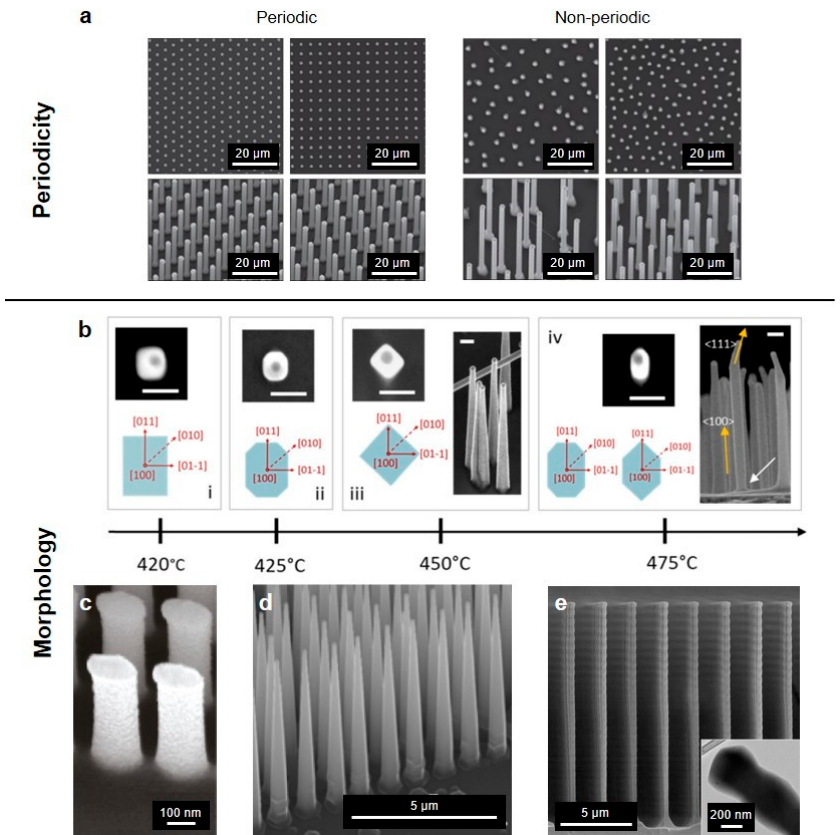
Figure 2. Scanning electron microscopy (SEM) images of geometrical variations in vertical nanowire arrays. ( a ) Periodic and non-periodic array arrangements. Top row: Top-view images of the nanowire arrays. Bottom row: Tilt-view (20°) images. ( b ) Side facets variations of the <100> oriented nanowires along the growth temperature. All scale bars are 100 nm. ( c ) Elliptical cross-section nanowires. The length of the semi-major and semi-minor axes are 100 nm and 50 nm, respectively. ( d ) Conical nanowires. ( e ) Diameter-modulated nanowires with the transmission electron microscopy (TEM)